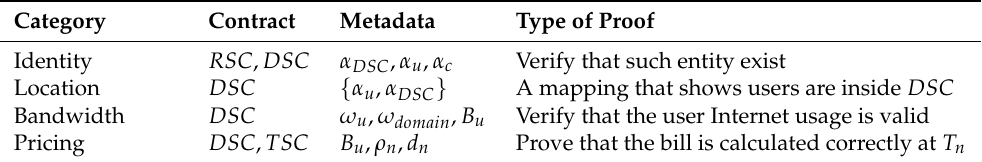
Table 3. List of metadata stored